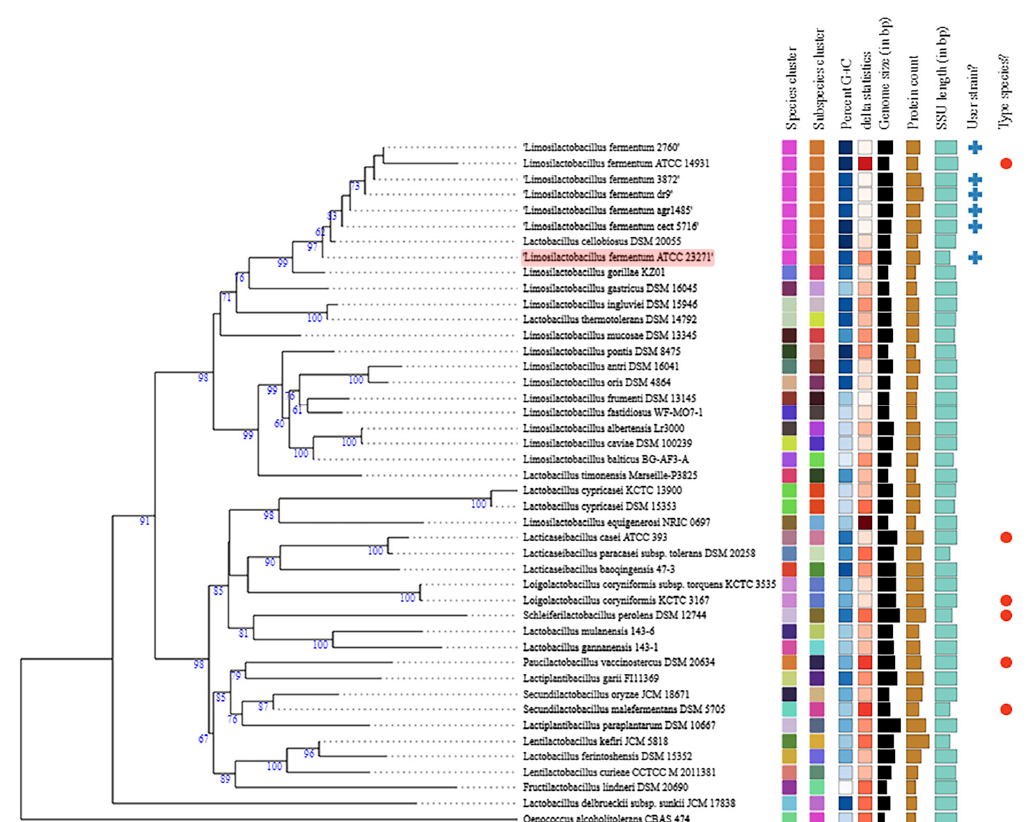
Figure 7. Phylogenetic tree of Limosilactobacillus fermentum ATCC 23271 and other bacterial genera available in the TYGS database. The tree was inferred using FastME 2.1.6.1 from ribosomal DNA. Branch lengths are scaled using the GBDP distance formula d5. The numbers above the branches are GBDP pseudo-bootstrap support values >60% of 100 replications, with an average branch support of 19.2%. The tree was rooted at the midpoint. Among the 13 exclusive clusters of L. fermentum ATCC 23271, OrthoVenn 2 analysis revealed 37 proteins that were most related to transposition. However, manual analysis showed only 16 ORFs, which included seven encoding transposases and six encoding hy- pothetical proteins, of which one sequence showed similarity to an L. reuteri hypothetical protein, two sequences that did not show similarity to any described protein and one en- coded a chloride transporter, as evidenced by UniProt analysis. 3.2. Putative Genes Associated with Probiotic Properties Genes for the following probiotic features were searched within the genome: toler- ance to stress conditions, production of lactic acids, production of adhesion structures, production of antimicrobial peptides and safety for human use. Genomic analysis de- tected 21 genes encoding proteins that may be related to the ability to tolerate the secretion of digestive enzymes, bile salts and acidic pH. Among them, genes for sugar metabolism and production of L-lactic acid were also present in the genome (Table 2).